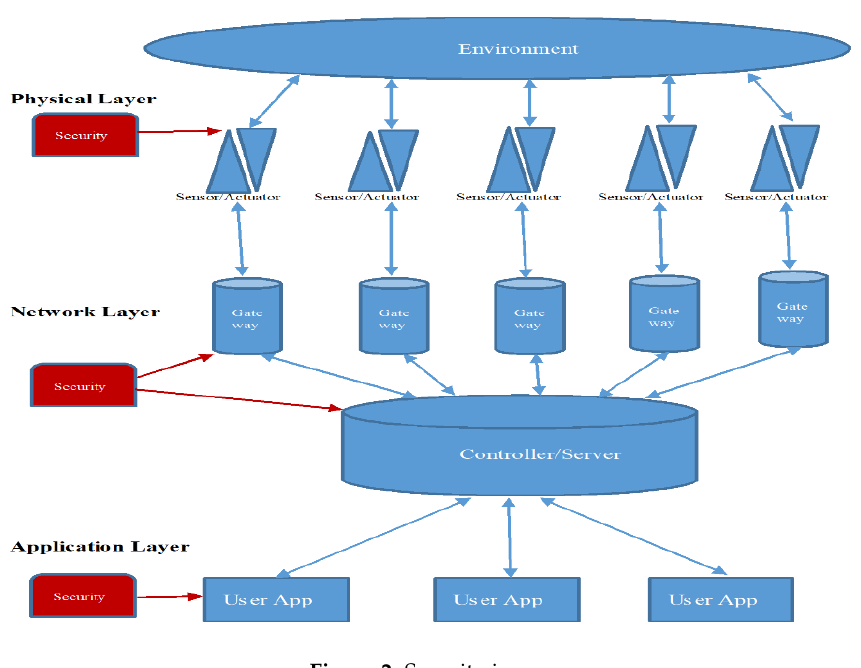
Figure 2. Security issues.